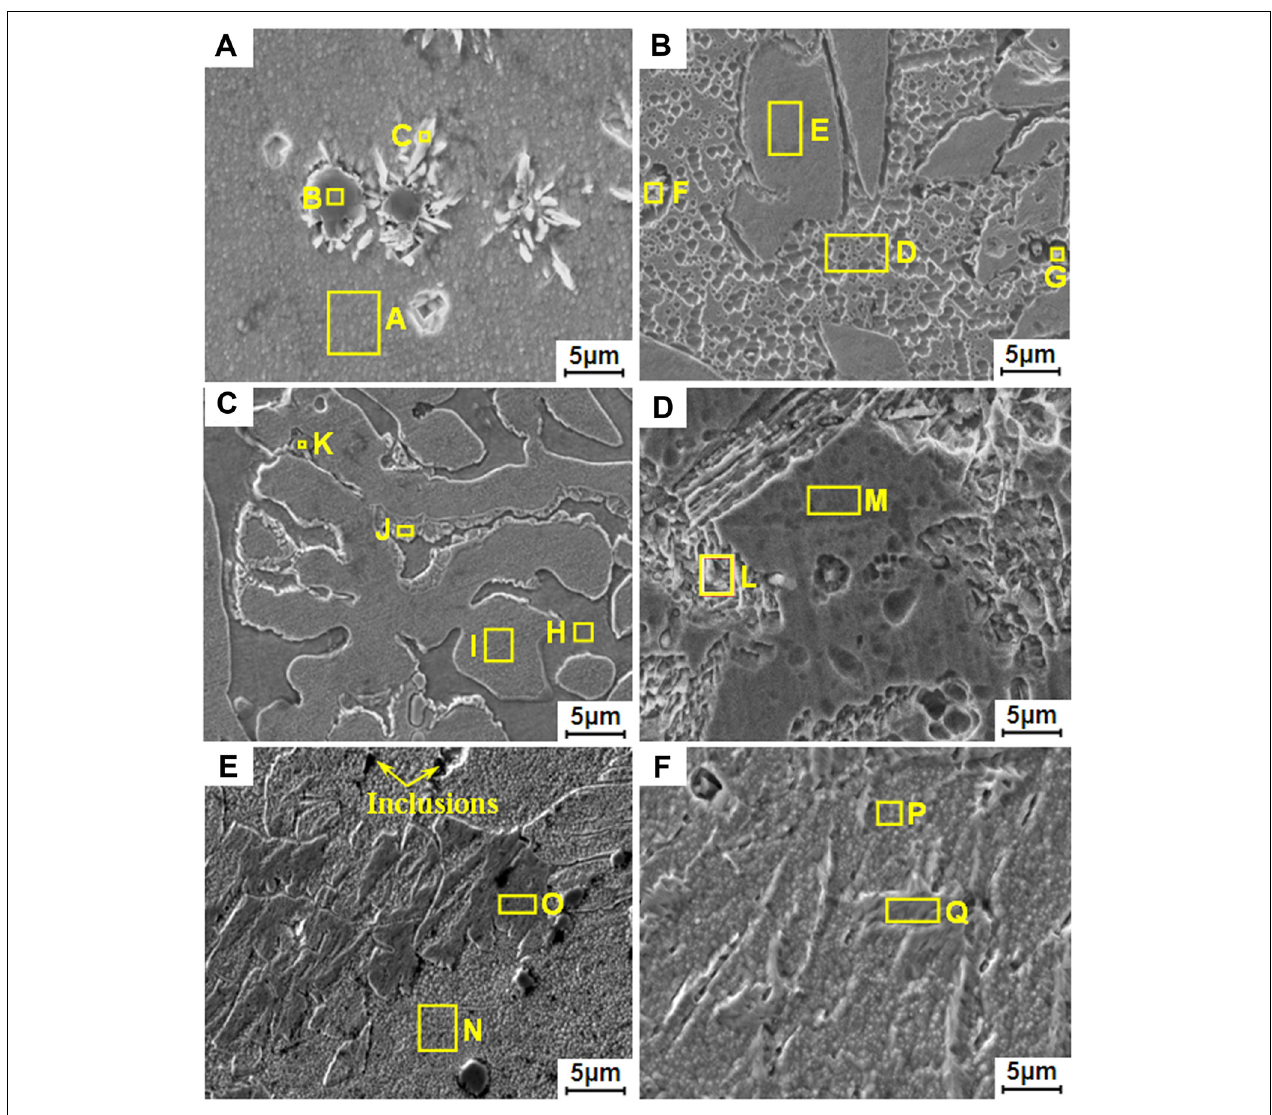
FIGURE 4 | Scanning electron microscope results of 2205 DSSs prepared with different Fe 2 O 3 excess percentages: (A) 0%, (B) 2.5%, (C) 5.0%, (D) 7.5%, (E) 10.0%, and (F)